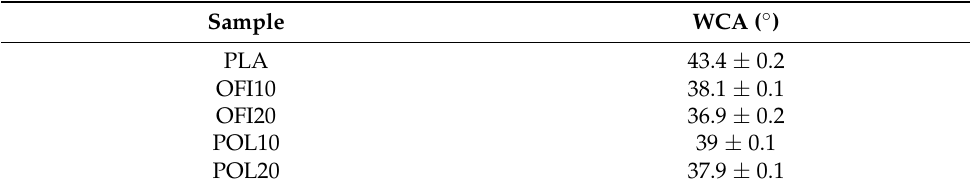
Figure 14. Representative WCAs of 3D printed PLA and related biocomposites. Table 8. WCA mean values and standard deviations collected from measurements on surfaces of FDM samples.